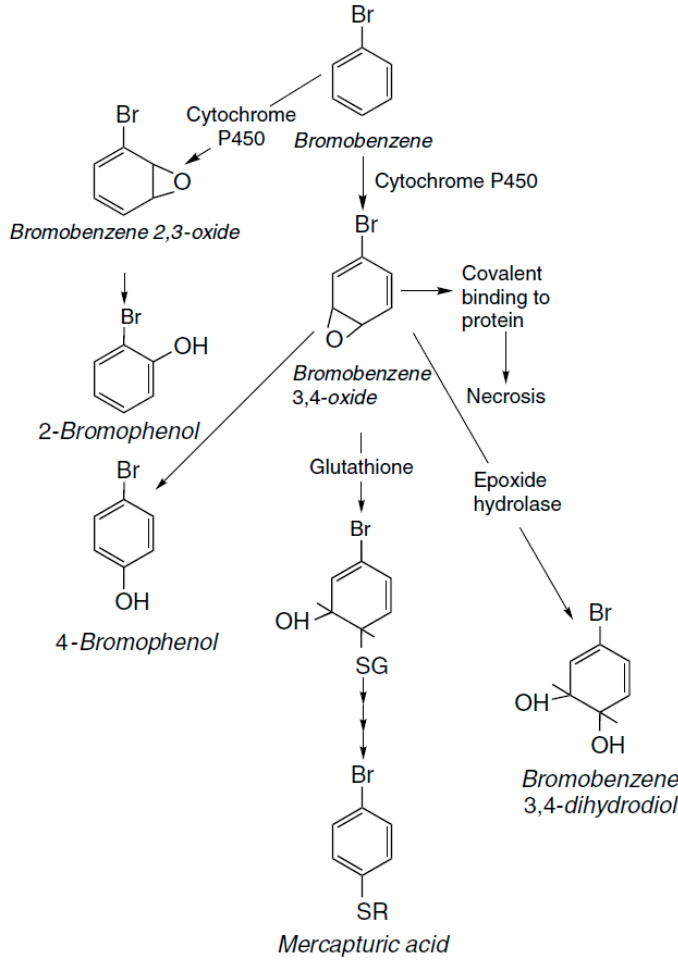
Figure 4. Metabolic pathways for bromobenzene (Reproduced with permission from [63]; published by Wiley, 2011).